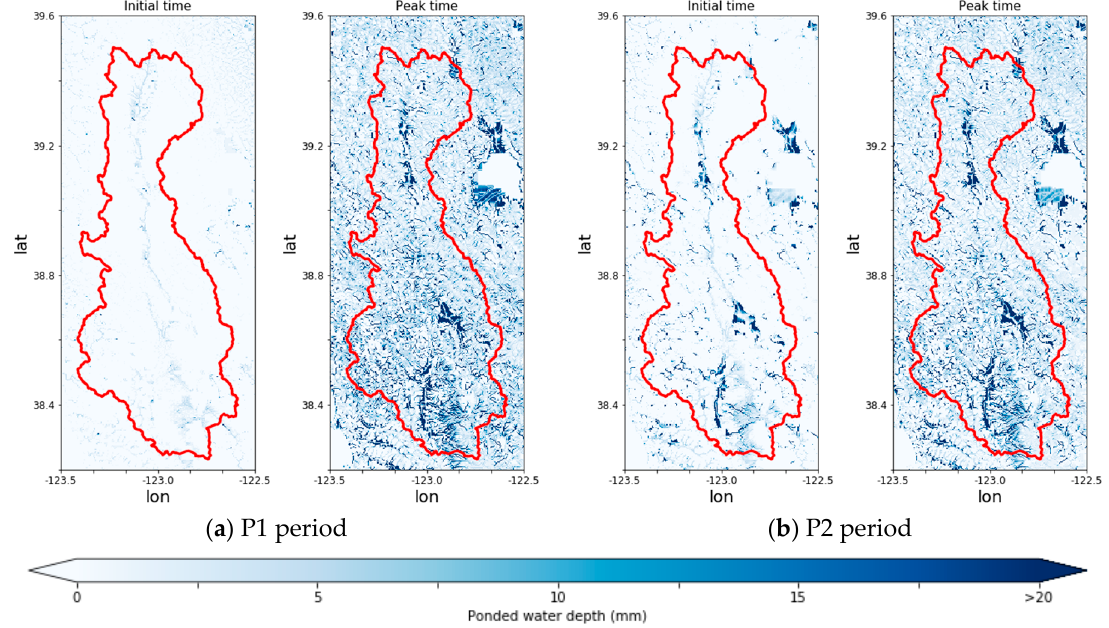
Figure 9. Distribution of direct runoff depths at initial and peak times for ( a ) P1 and ( b ) P2 periods.